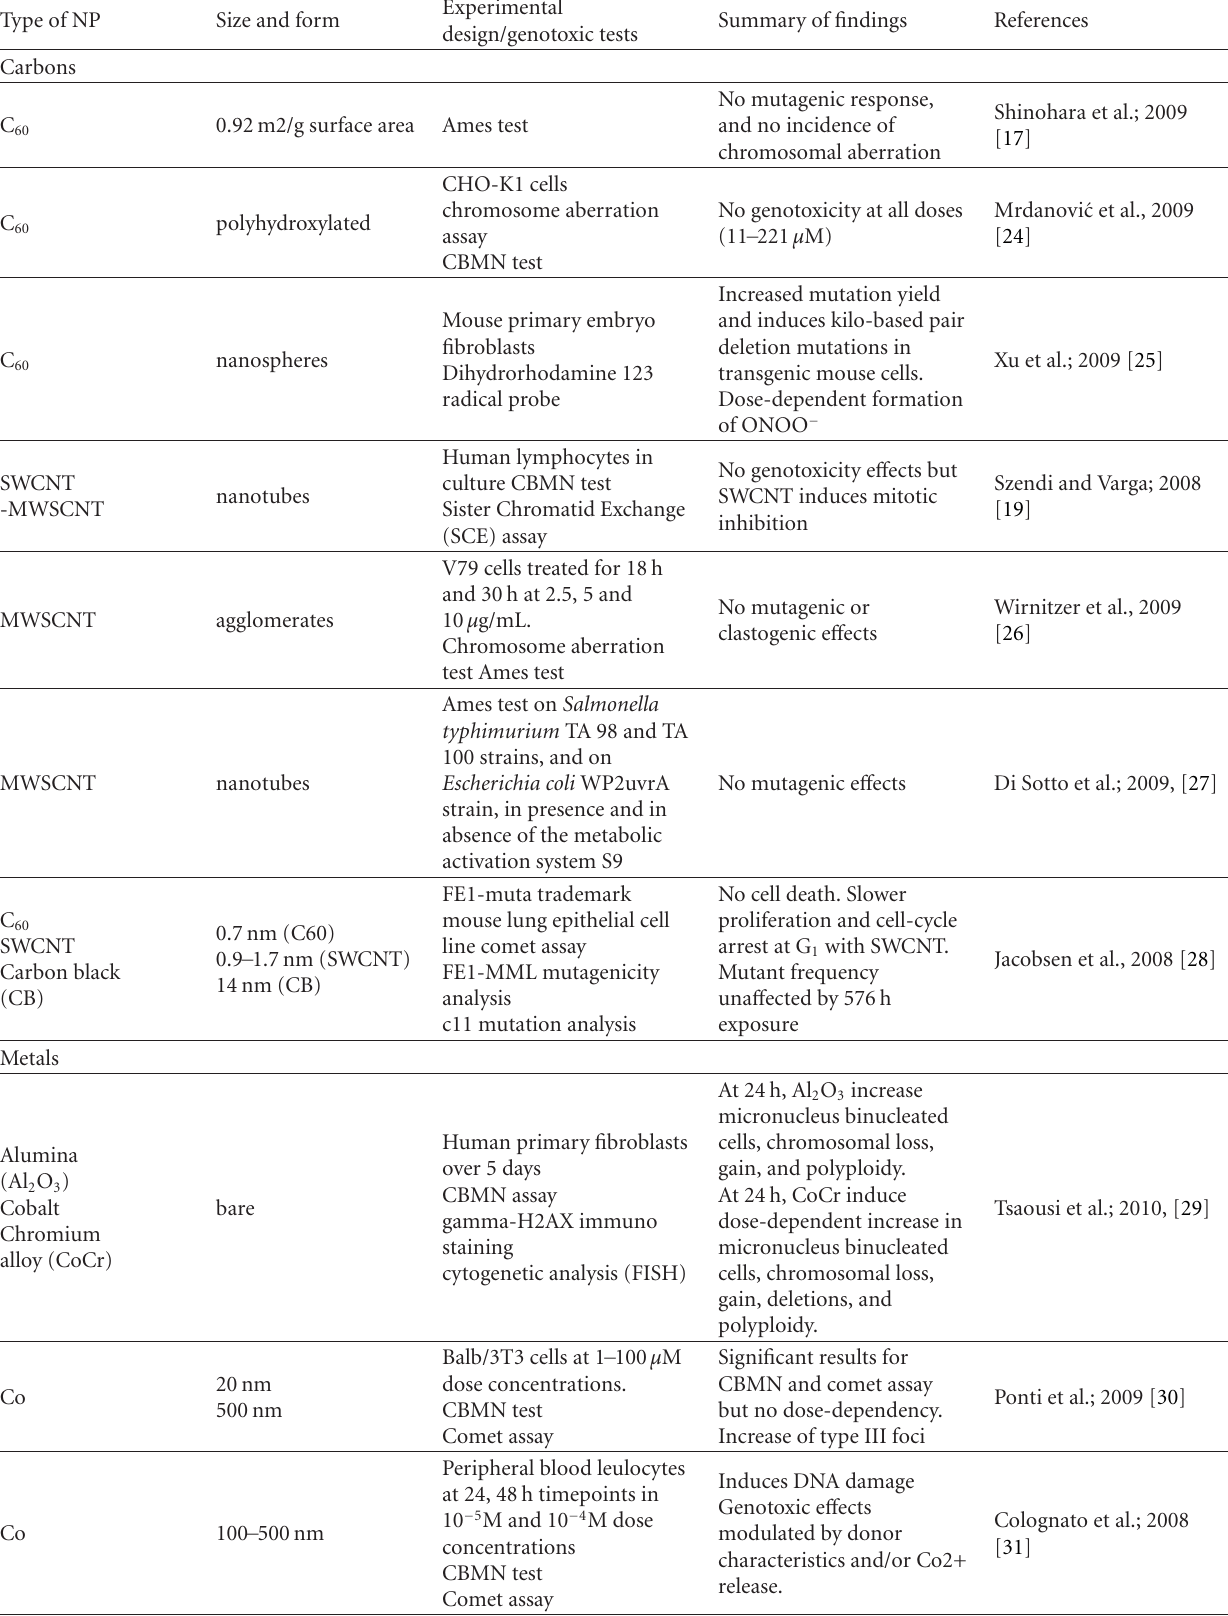
Table 2: Selected in vitro genotoxicity studies on